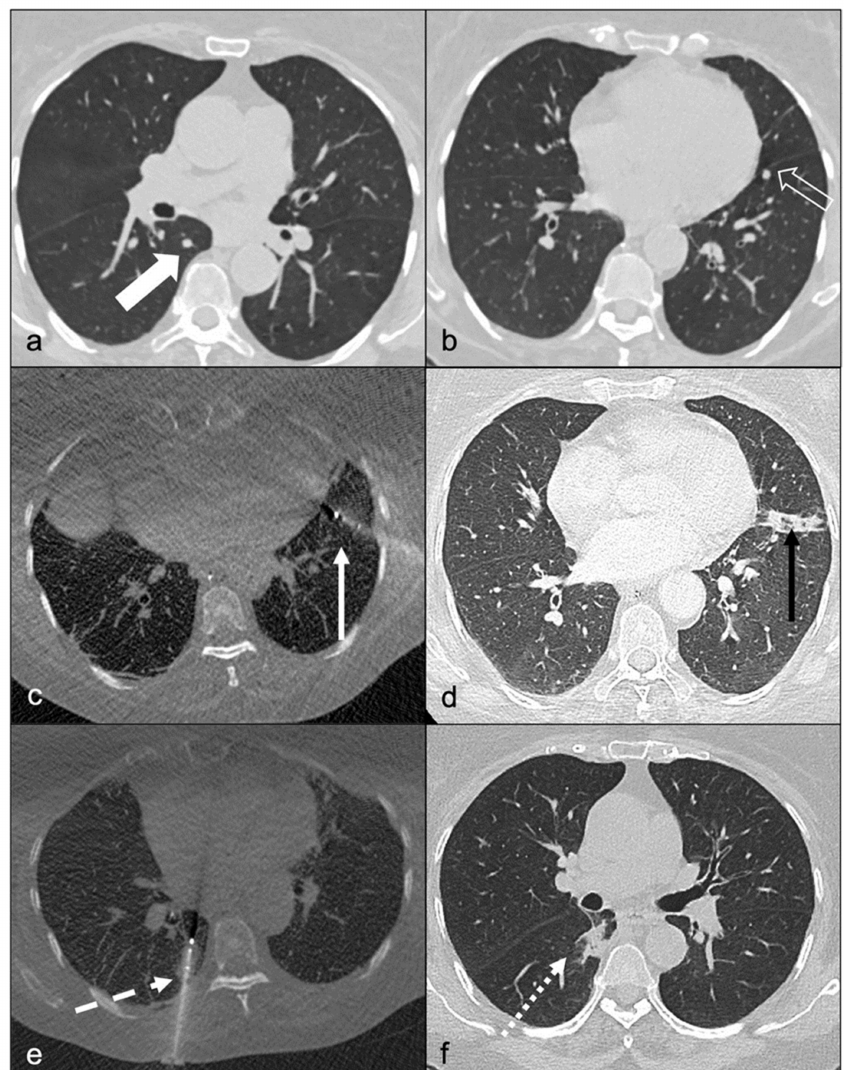
Figure 3. Complete response obtained with mitotane plus multiple locoregional treatments: a 65-year- old female patient with two small lung metastases in ( a ). right lower lobe and ( b ). oblique fissure. ( c ). Cryotherapy of the left fissure nodule complicated by a pneumothorax, which contraindicated right nodule treatment during the same intervention. ( d ). Left nodule sequel one month after cryotherapy with no residual pneumothorax; partial response obtained. ( e ). Right lower lobe nodule percutaneous treatment 2 months after the previous treatment. ( f ). Right nodule sequel one month after the second treatment; complete response was